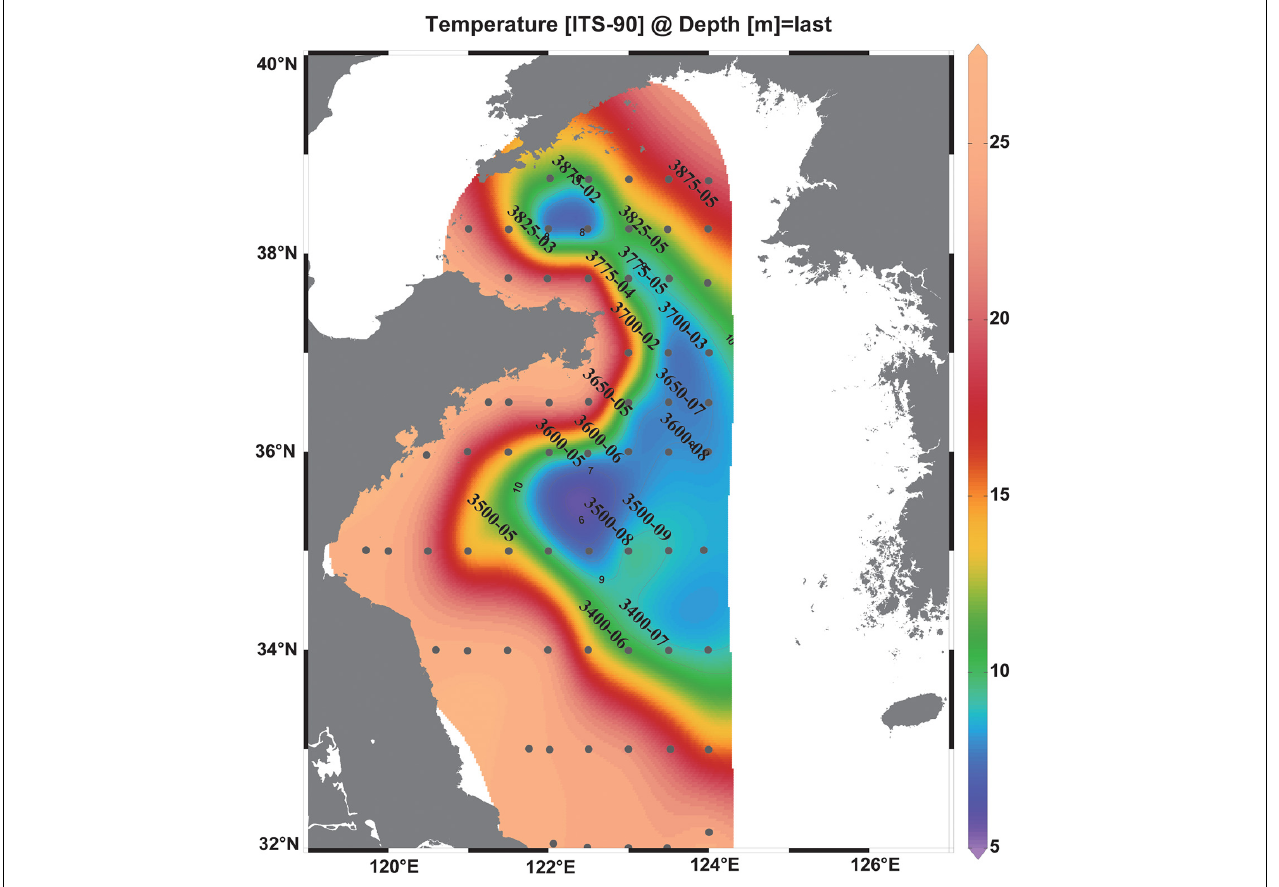
FIGURE 1 | Map of the research area of the summer cruise 2017 and bottom temperature. The CTD stations were assigned black circles, and the VPR stations are named. The isolines indicate the bottom water temperature ( ◦ C) with 1 ◦ C increments. The Yellow Sea Cold Water Mass is denoted with the boundary defined by the 10 ◦ C isotherm (Fei et al.,